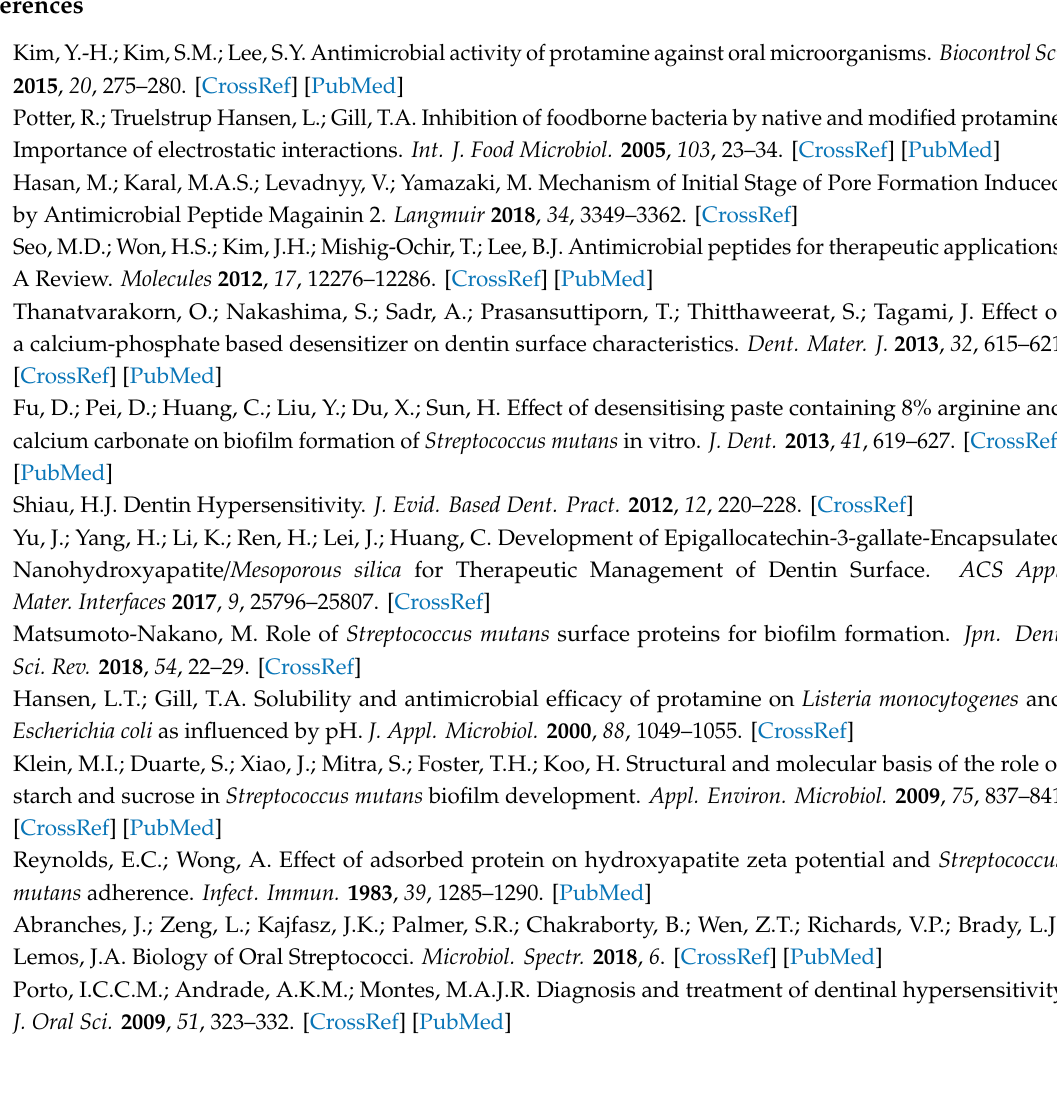
Figure S1: Adsorption isotherm of protamine, Figure S2: 3D architecture and cross section of biofilms on the disc, Figure S3: Calcium ion concentration of the supernatants after cultivation of S. mutans without sucrose, Figure S4: Calcium ion concentration of the supernatants after cultivation of S. mutans with 1%